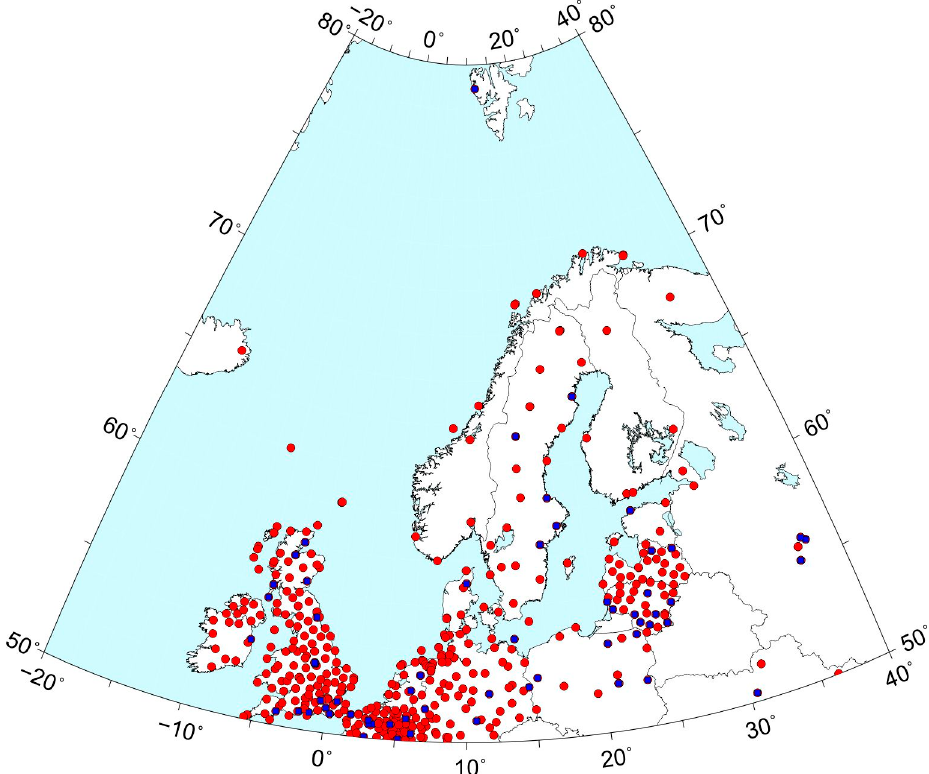
Figure 1. The 469 GPS permanent stations used in this research with observations processed by the NGL laboratory in PPP mode. The 62 stations for which the polynomial trend model is employed in Equation (1) are marked with blue dots. See text for details.